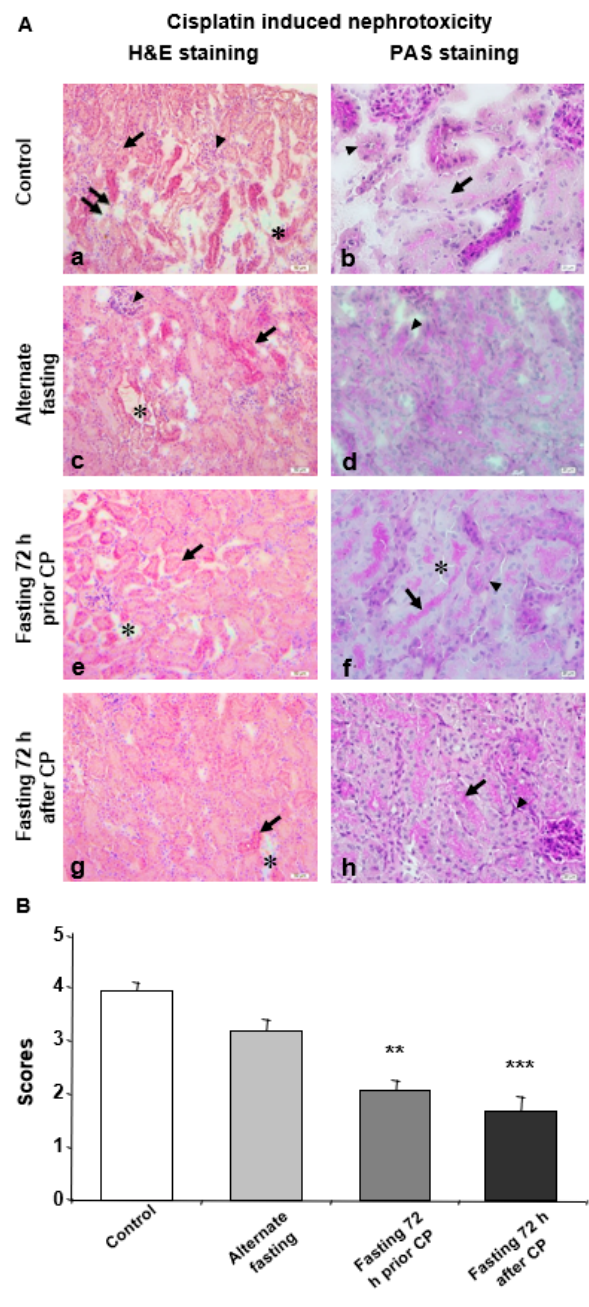
Figure 1. Seventy-two hours of fasting improves the histological parameters for CP induced nephrotoxicity. ( A ) Microphotographs of H&E and PAS staining. ( a , b ) Kidney tissue of the control group was shown. ( a ) Damaged tubules and staining difference (arrow), glomerular degeneration (arrowhead), loss of epithelial cells lining inner part of tubule (double arrow) and small gaps between the tubules (*); and ( b ) basal membrane degeneration of dysmorphic tubules (arrowhead) and degeneration in epithelial cells lining the inner part of the tubules (arrow) were demonstrated. ( c , d ) Kidney tissue of the alternate fasting (AF) group was shown. ( c ) Damaged tubular shape/appearance and staining difference (arrow), glomerular degeneration (arrowhead), ripped off-like gaps between the tubules (*) and ( d ) degeneration of the basal membrane (arrowhead) were demonstrated. ( e , f ) Kidney tissue of fasting 72 h prior CP (72P) group was shown. ( e ) Small damage and widening between the tubules (*) and tubule shape (arrow), decrease in glomerular size and ( f ) brush border at the apical surface of the epithelial cells lining the inner part of the tubule (arrow) and PAS (+) reaction of basal membranes (arrowhead). No PAS (+) reaction of basal membranes was observed at separated